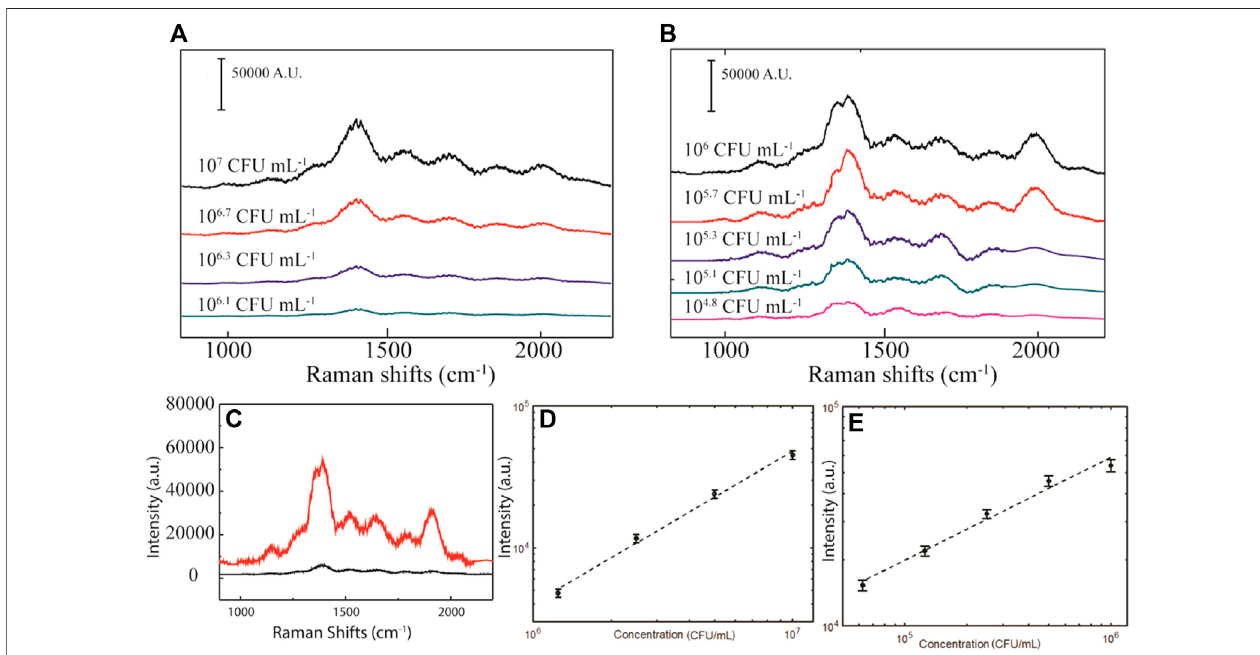
FIGURE6|(A) Ramanspectrumfor L.monocytogenes atdifferentconcentrations. (B) SERS spectrum ofthe L.monocytogenes combined withpAb-Lis-AuMNs. (C) ComparisonoftheRamanspectraat10 6 CFUml − 1 showingdramaticenhancementofthecurveaftermagneticaggregation. Ramanpeakintensityat1388cm − 1 for the (D) L. monocytogenes and (E) SERS L. monocytogenes with pAb-Lis-AuMNs as a function of the pathogen concentration while under the presence of a magnetic fi eld (35